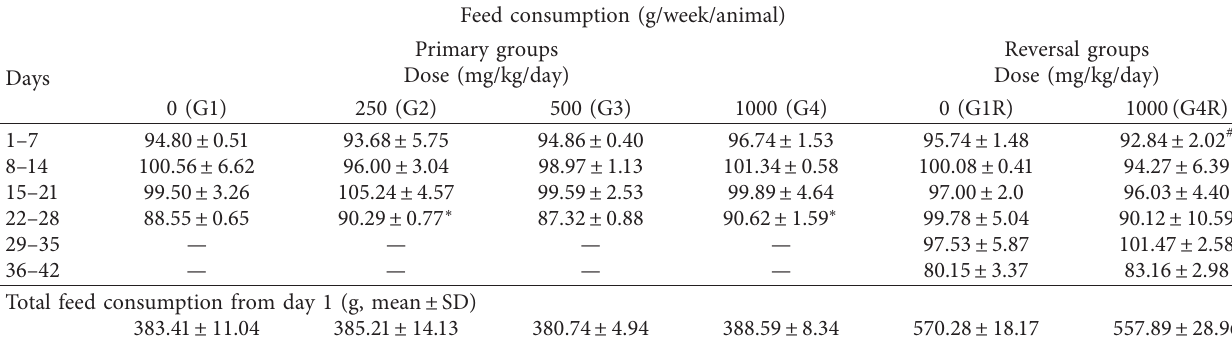
Table 2: Effect of oral administration of GMCT on feed consumption by female Wistar